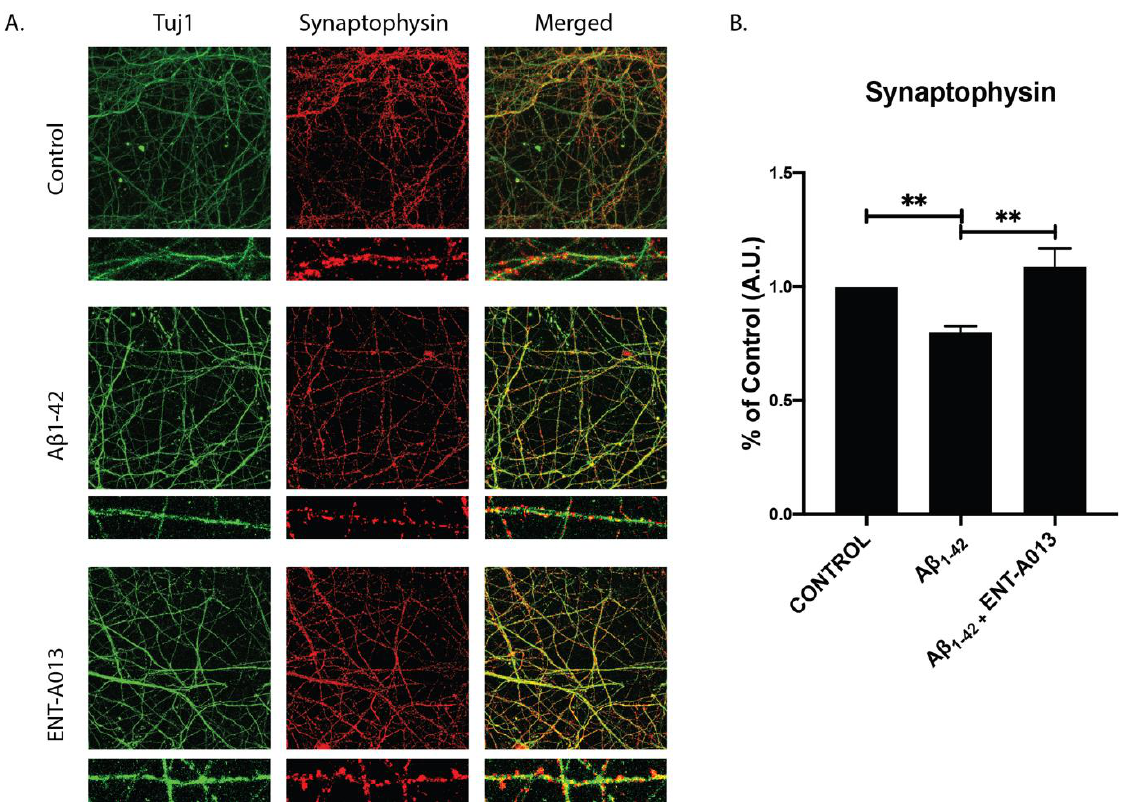
Figure 6. ENT-A013 protects against Aβ -induced synapse loss. ( A , B ) Primary hippocampal neurons treated for 4 h with oligomeric Aβ in the presence of ENT -A013 and stained against synaptophysin to assess synapse number. Total Synaptophysin area was normalized to total Tuj1 area in each image. Representative images from 4 – 5 independent experiments. Data are shown as ±SEM. One-way ANOVA, Tukey’s Test correction: ** p < 0.01.